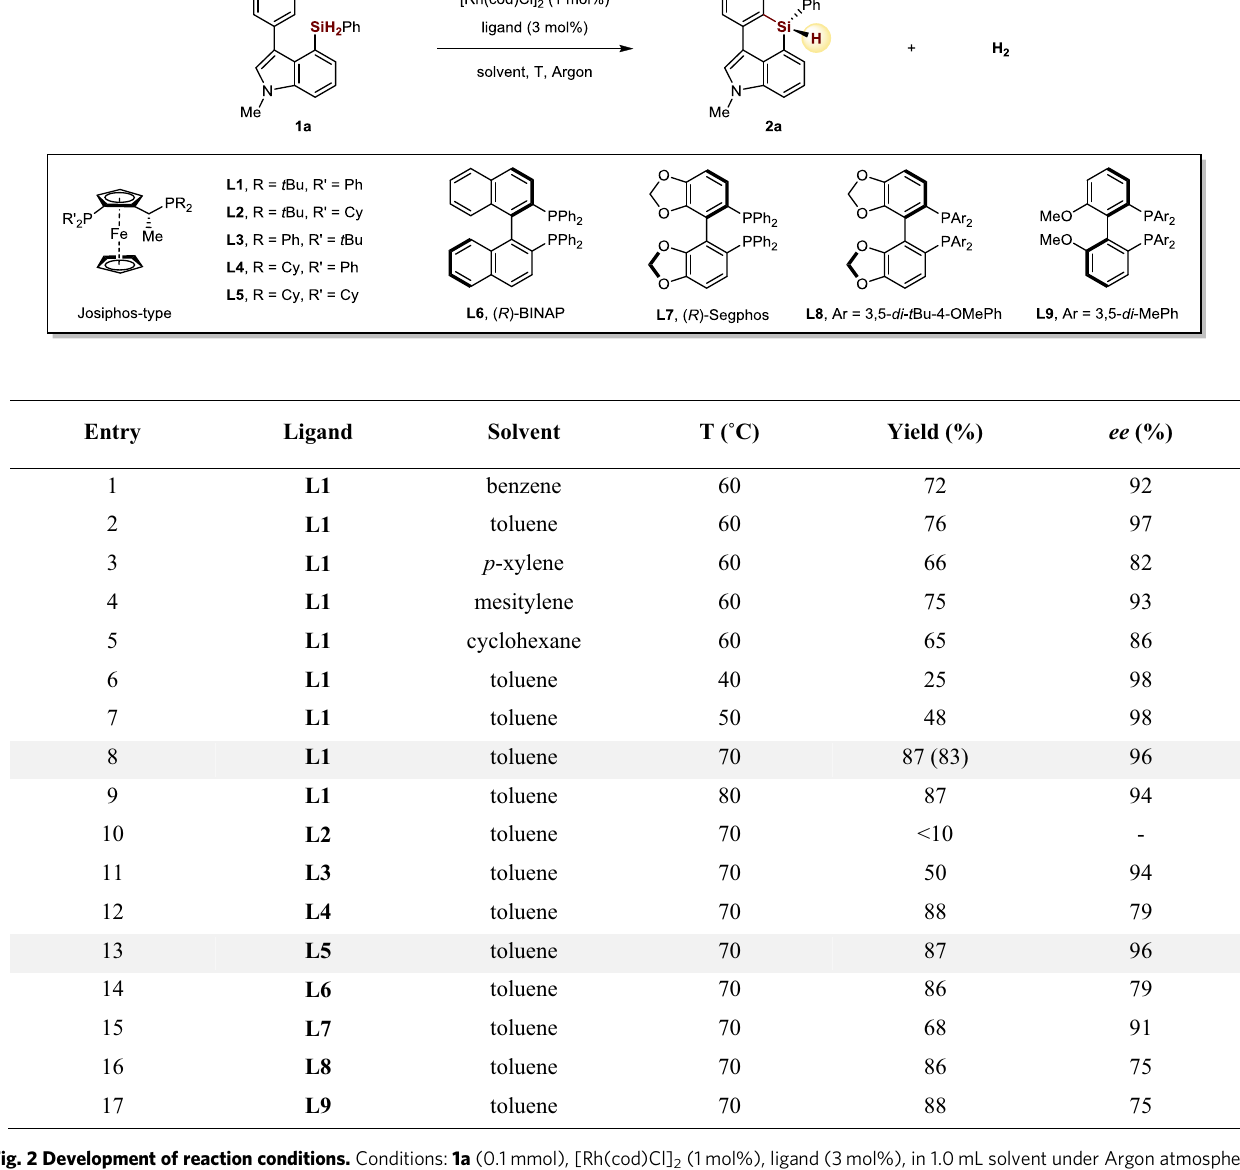
Fig. 2 Development of reaction conditions. Conditions: 1a (0.1 mmol), [Rh(cod)Cl] 2 (1mol%), ligand (3mol%), in 1.0mL solvent under Argon atmosphere. The yield was determined by 1 H NMR using CH 2 Br 2 as internal standard, yield in brackets is isolated yield. The ee values were determined by chiral